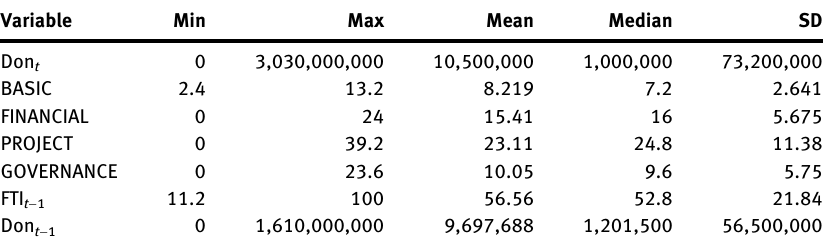
Table  : Descriptive